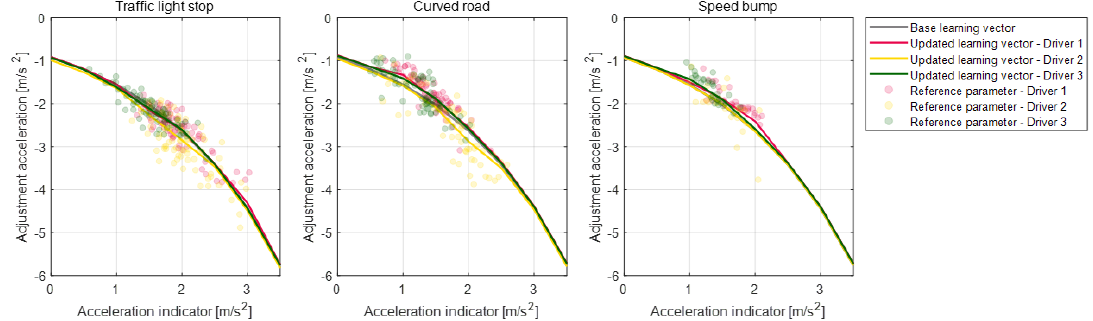
Figure 21. Learning results for parameter adjustment acceleration for each road